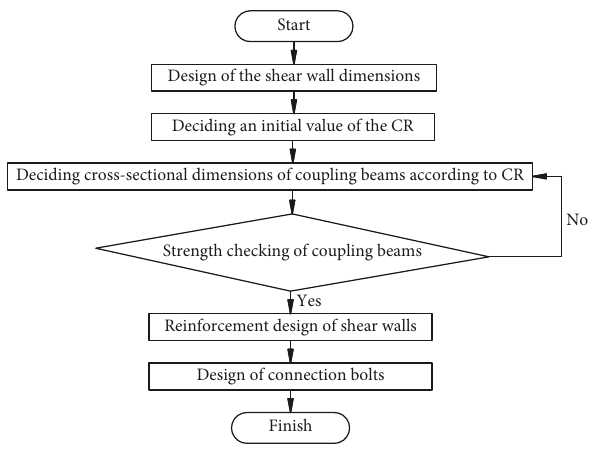
Figure 5: Flow chart of design